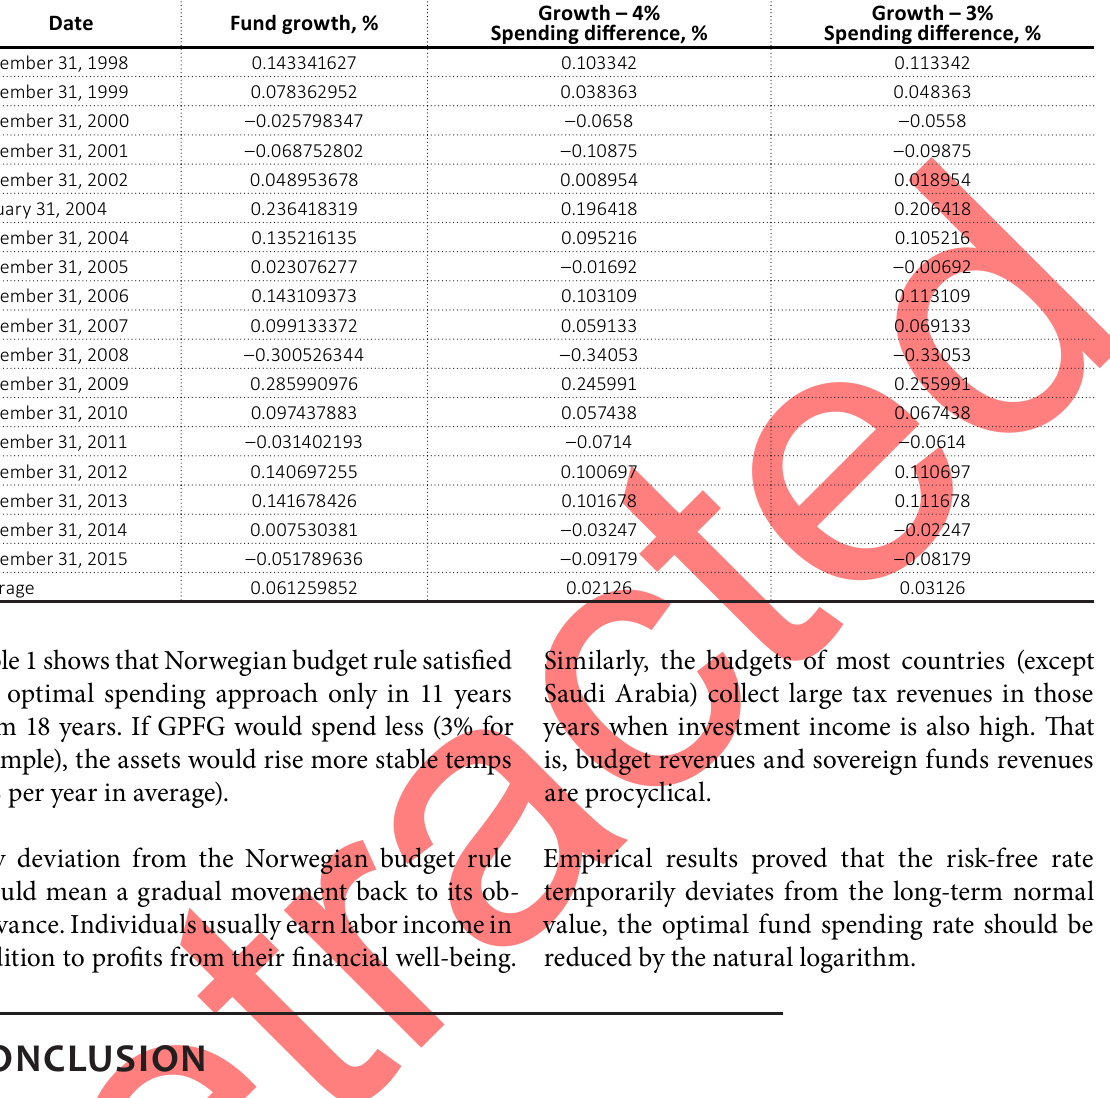
Table 1. Share of annual spending of the GPFG